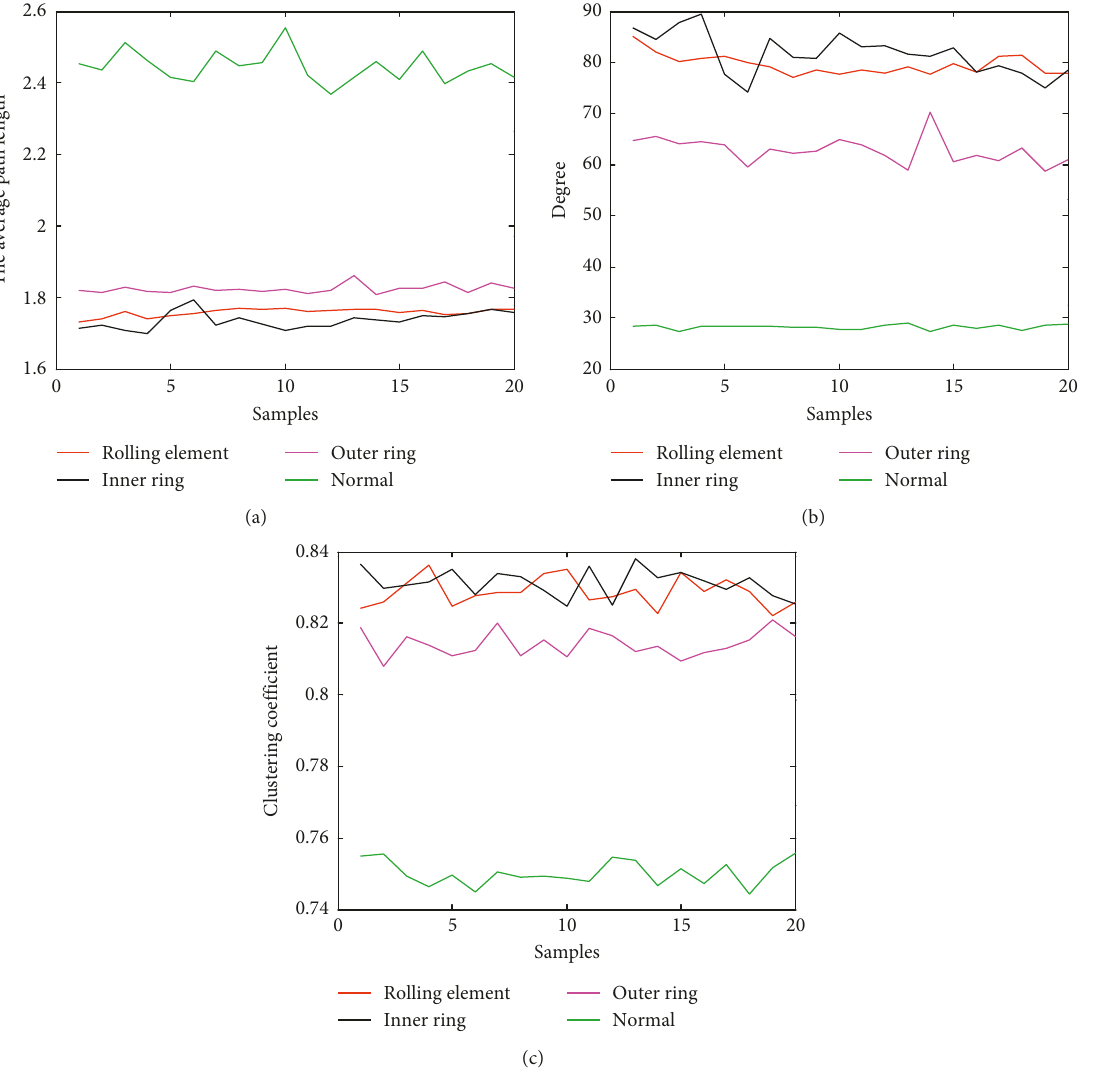
Figure 9: Feature distribution of four bearing states. (a) The average path length. (b) Degree. (c) Clustering